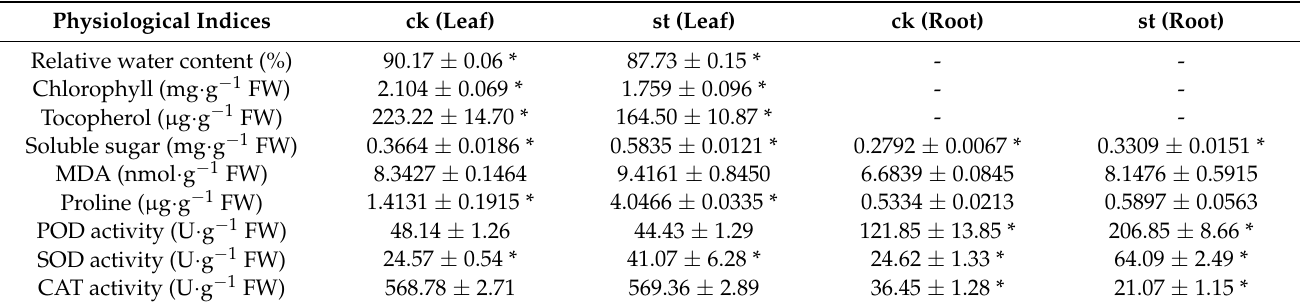
Table 1. Physiological parameters under salt